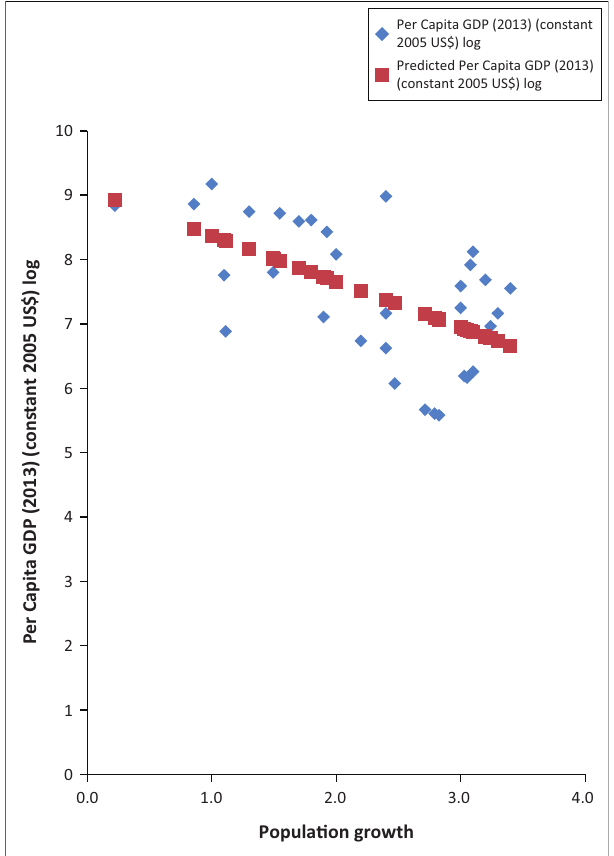
FIGURE 2: Country-specific savings rates. FIGURE 1: Population growth and incomes (annual %